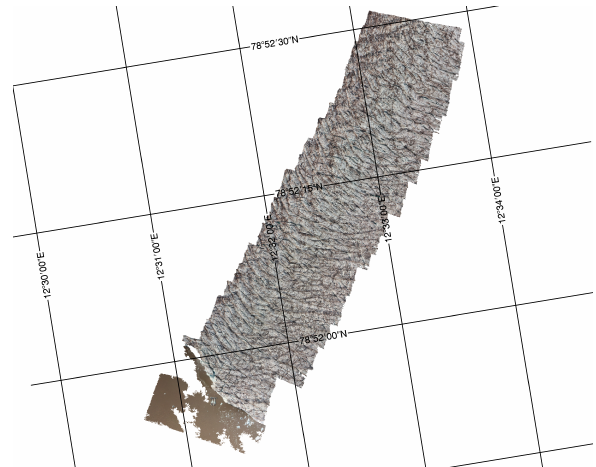
Figure 6: Orthophoto mosaic of the Kronebreen glacier terminus.